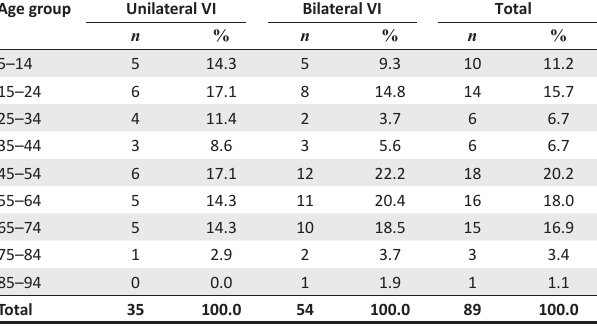
Note: incl CF@1m, including counting fingers at 1 meter. TABLE 2: Distribution of visual impairment with age. Age group Unilateral VI